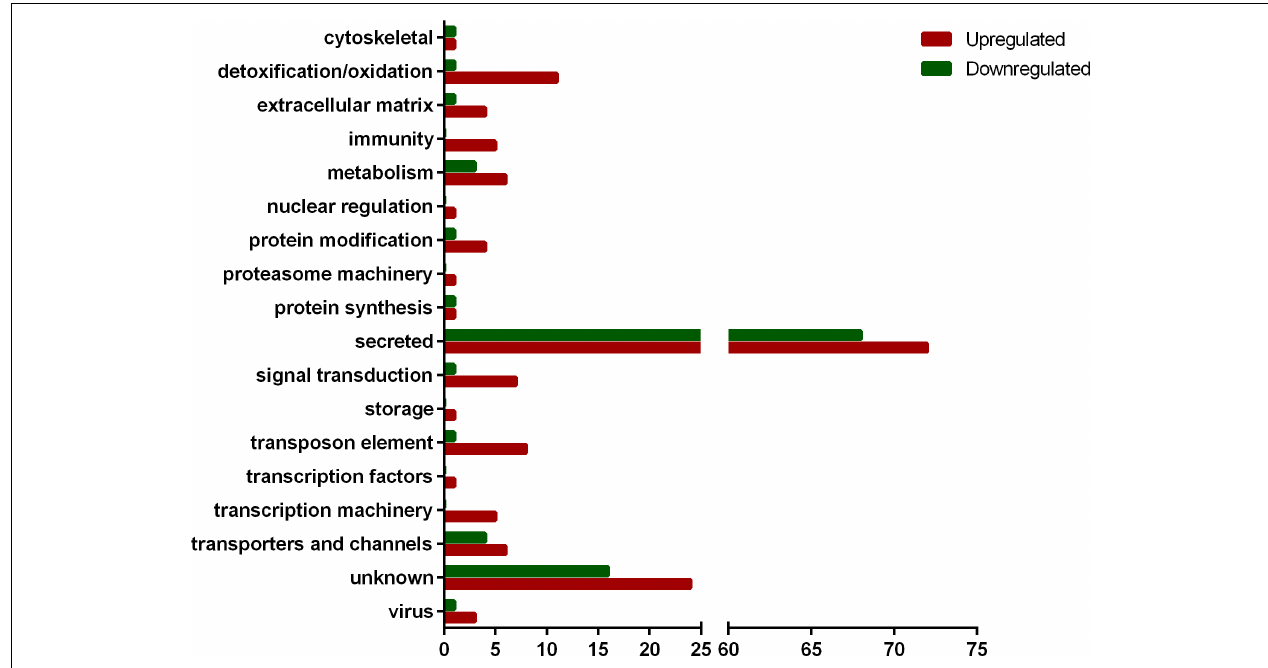
FIGURE 1 | Functional classification of CDSs differentially expressed in SG of R. rickettsii -infected A. aureolatum ticks.